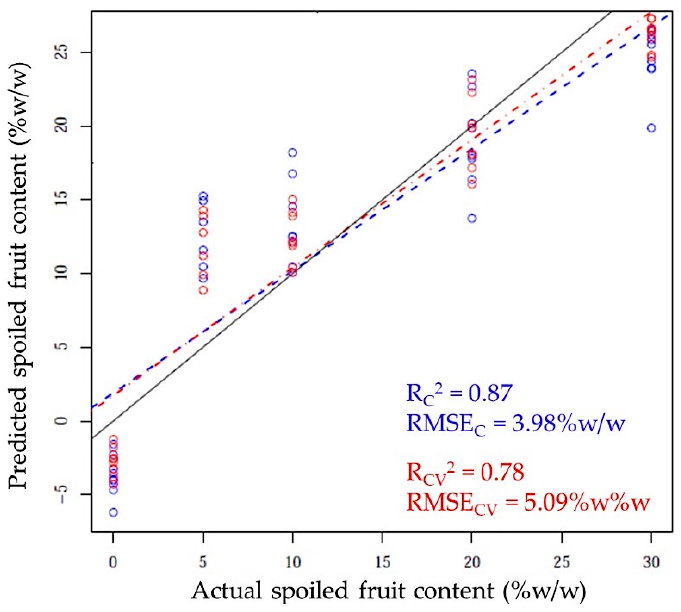
Figure 7. PLSR prediction of “24 °C Injury” fruit content in raw plum juices with “LOO” cross- validation ( N = 39). Table 9. LDA classification models on the e-tongue results of raw plum juice mixtures with second parallel sample vali- dation when the “24 °C Injury” fruit content was used as class variable ( N = 39).